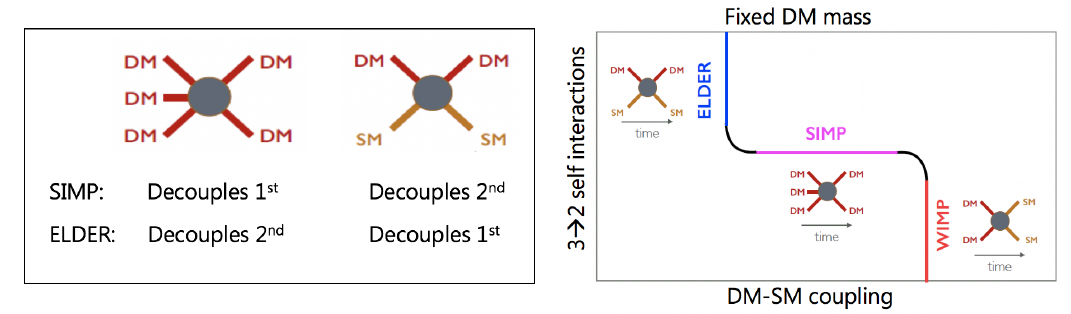
Figure 4: Left: SIMPs versus ELDERs. Right: The phase diagram of DM mechanisms in the plane of DM-SM couplings versus 3 → 2 self-couplings of DM, at fixed DM